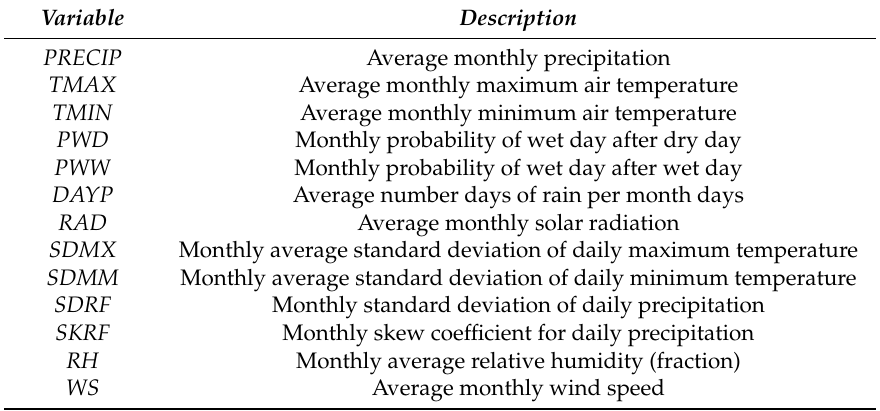
Figure 2. The workflow for creating forcing ensembles. Table 2. 13 climate variables summarized from General Circulation Models (GCMs) for WXGN use to generate the ensemble of daily climate